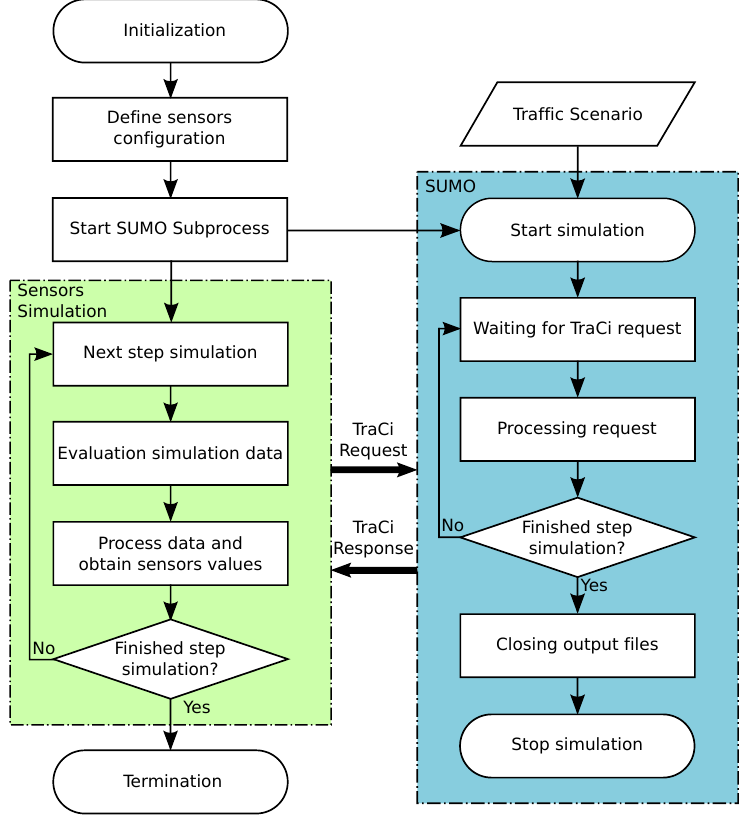
Figure 2. Block diagram of the sensor modelling and simulation